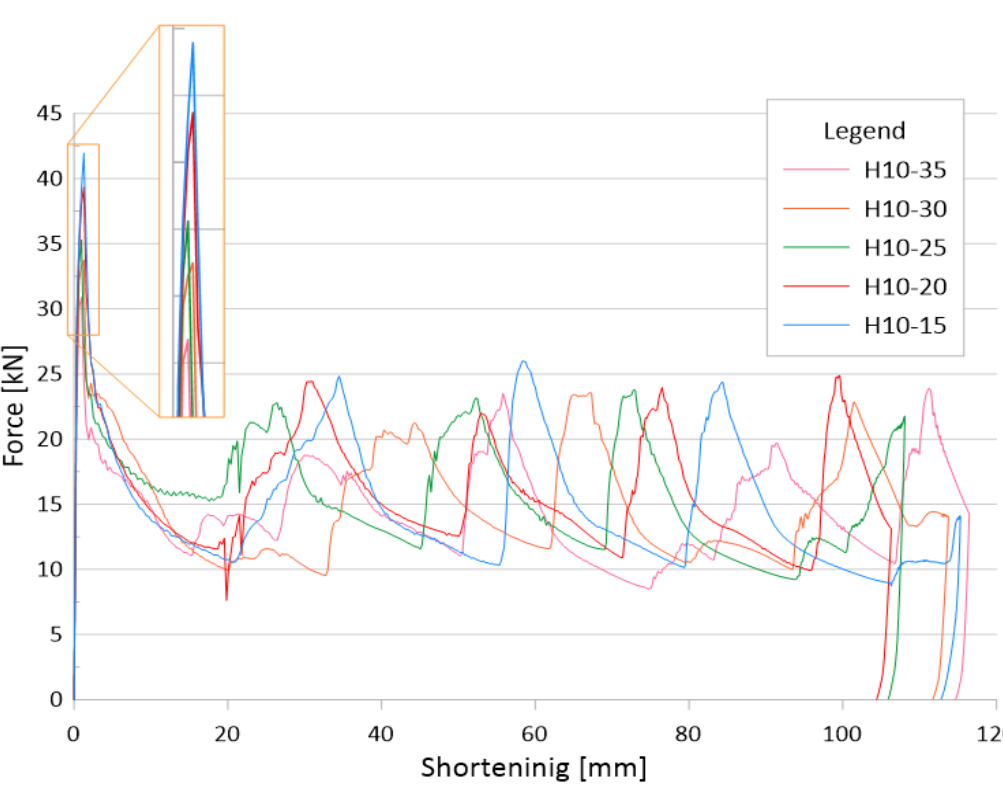
Figure 4. Force waveforms for all samples with a trigger height of 10 mm.